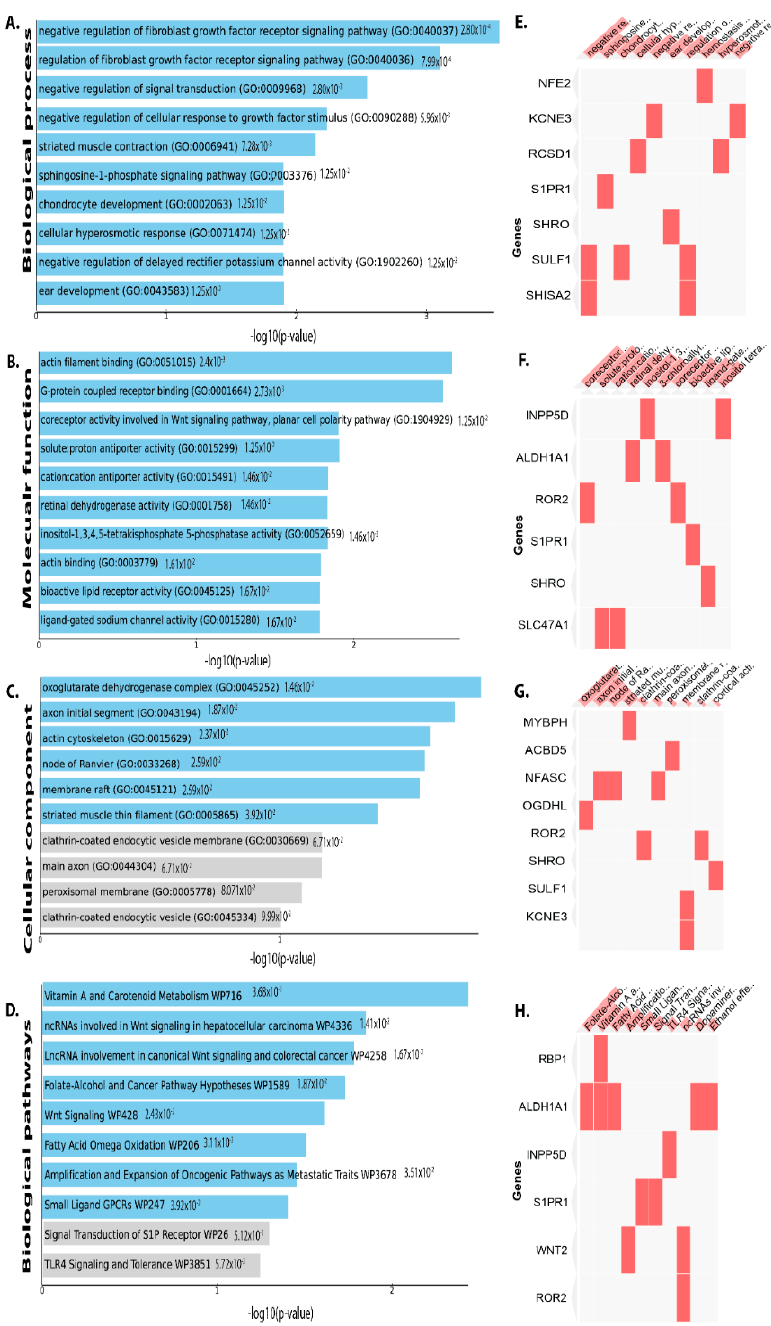
Figure 4. DEGs that have been downregulated are classified using gene ontology. Plots of the log- p value and the enriched enrichr-based combination score. The p value indicates the significance of enrichment and the number of genes/proteins in the category. Using downregulated genes, Clustergram was generated by Enrichr. Genes associated with each term are indicated by the red cells in the matrix, depicting top 10 enriched terms with p -value < 0.05 ( A ) Biological process ( B ) Molecular function ( C ) Cellular component and ( D ) Biological pathway. ( E ) Clustergrams display the genes associated with the top 10 biological processes in red cells in a matrix. ( F ) In clustergram, the red cells in the matrix indicate the genes associated with the top 10 significant molecular function. ( G ) In clustergram, the red cells in the matrix indicate the genes associated with the top 10 important cellular components. ( H ) Clustergrams display the genes related to the top 10 biological pathways in red cells in a